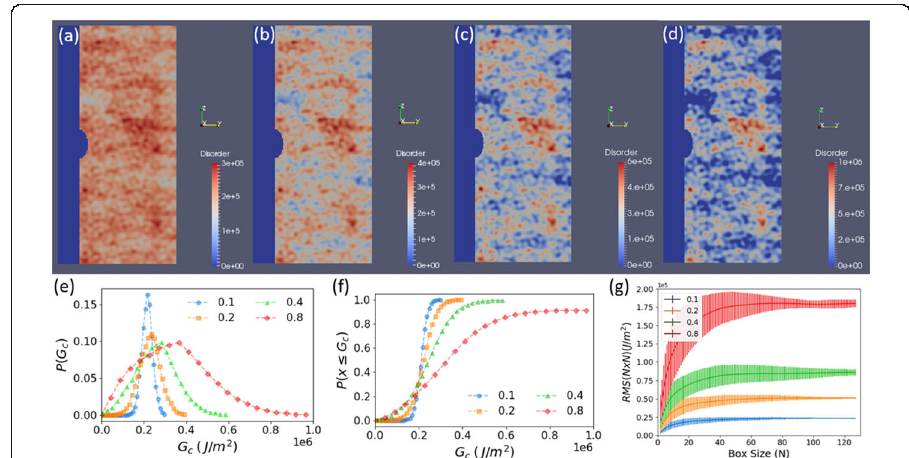
Fig. 3 Disorder distribution for local fracture tendency and spatial profiles: The progression of the disorder ratio, R G , for W = 0.125 mm with a system size of L x = 8 μ m, L y = 0.5 mm, and L z = 1.0 mm where ( a ) has a disorder ratio of 0.1, ( b ) has a disorder ratio of 0.2, ( c ) has a disorder ratio of 0.4, ( d ) has a disorder ratio of 0.8, ( e ) and ( f ) are the probability density function (pdf) and cumulative distribution function (cdf), respectively, of the fluctuating phase field energy parameter of each node vs. the phase field energy parameter, and ( g ) is the autocorrelation lengthscale of the W-M function. The saturation of the autocorrelation function may be thought as the disorder correlation length (Alava et al.